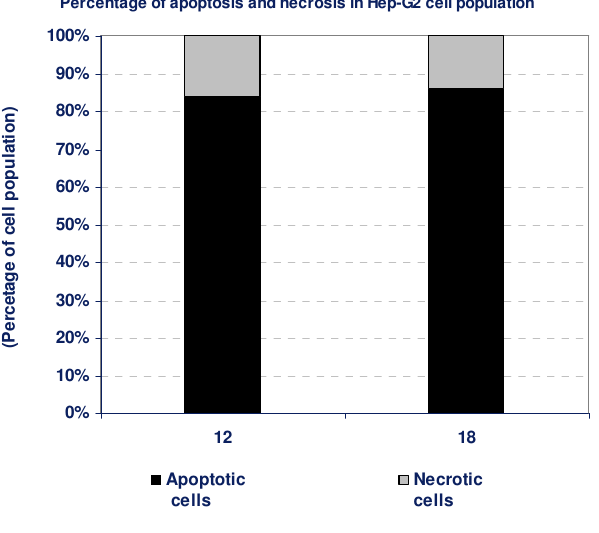
Figure 4. The type of cell death was investigated in Hep-G2 cells after the treatment with the promising cytotoxic compounds, using acridine orange/ethidium bromide staining to compare between the percentage of necrotic cells (grey segment) and the apoptotic cells (black segment). Data represent mean value ±